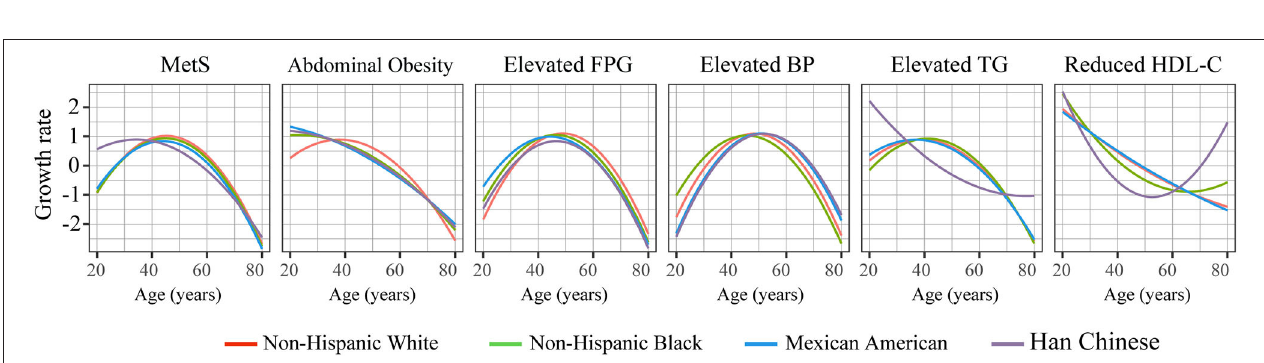
FIGURE 1 | The prevalence of metabolic syndrome (MetS) and its components with age across different races. Prevalence was estimated using a SWAN algorithm (shown as dots). The trajectory of the prevalence of MetS with age was fitted by cubic regressions (shown as lines). FPG, fasting plasma glucose; BP, blood pressure; TG, triglycerides; HDL-c, high-density lipid cholesterol; SWAN, sliding-window-based algorithm.